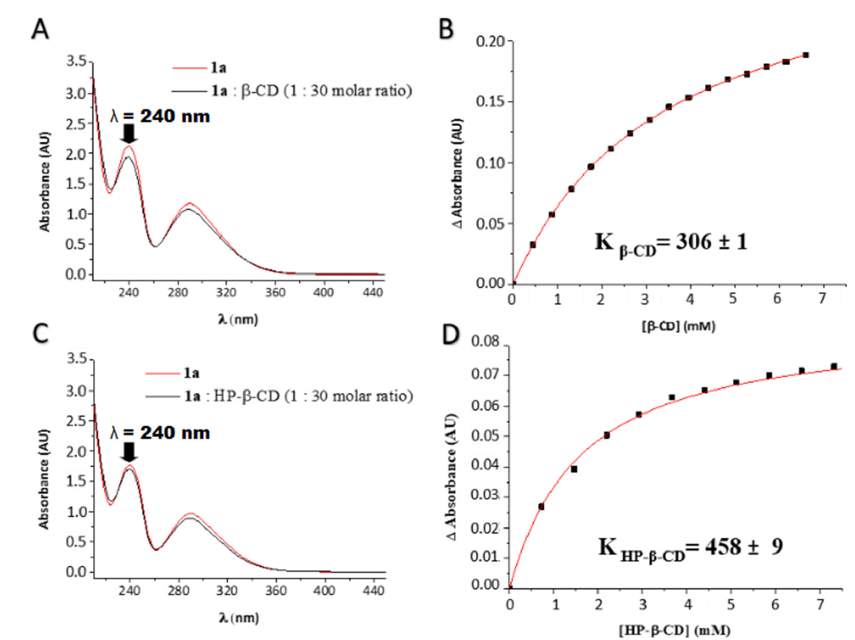
Figure 7. ( A , C ) Absorption spectra of 2.2 × 10 − 4 M of 1a in the presence of β -CD and HP- β -CD (6.6 × 10 − 3 M), respectively. ( B , D ) Change in the maximum of absorbance at 240 nm ( Δ A) as a function of the CD concentration.